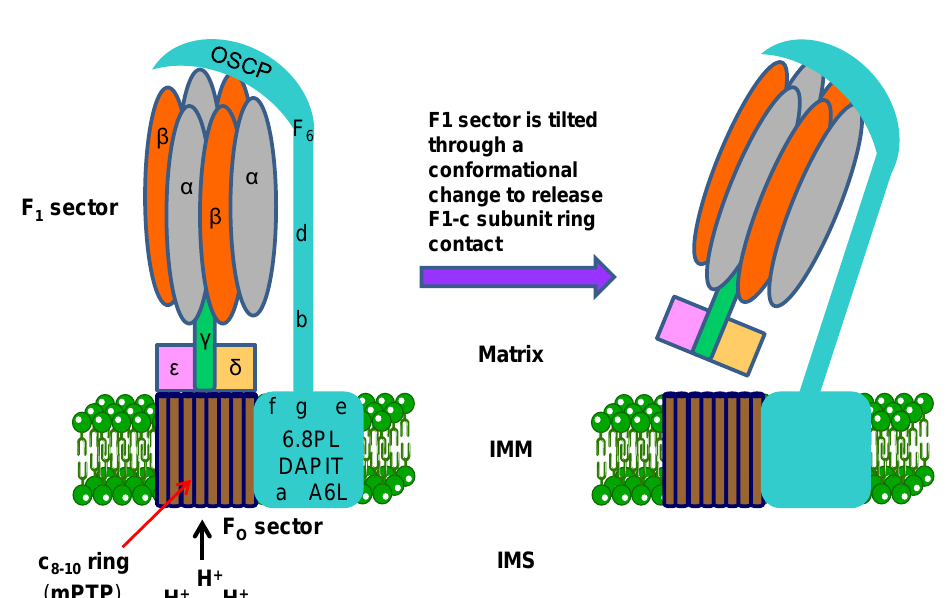
Figure 6. Organization of subunits in F 1 F O –ATP synthase in mammalian mitochondria and opening of the mPTP. OSCP, F6, d, and b constitute the F O peripheral stalk. Under certain circumstances, the F O peripheral stalk and F 1 sector are tilted to free the c-subunit ring channel from the side facing the matrix, thus opening the mPTP (see [190]). See text for details. IMM, inner mitochondrial membrane. IMS, inter-membrane space. mPTP, mitochondrial permeability transition